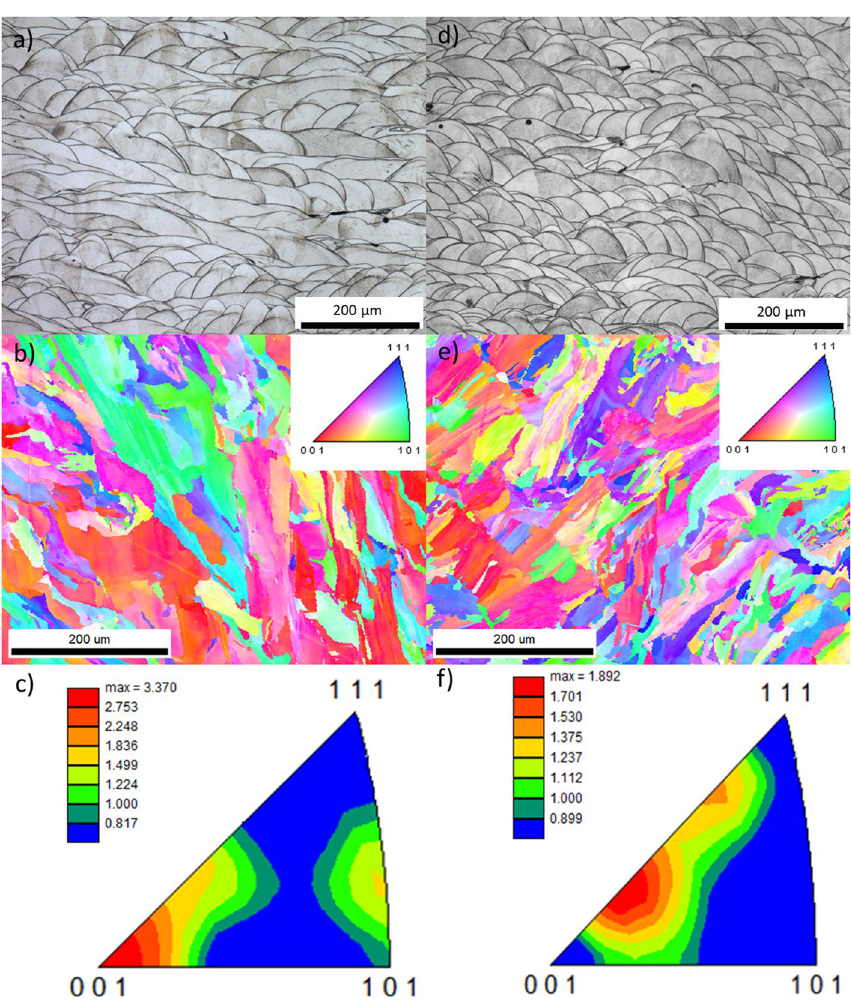
Figure 8. Optical micrographs of the etched microstructure, with the melting pools visible (in CoCr printed from virgin powder ( a ) and the reused powder ( c )) EBSD results and orientation maps (in CoCr printed from virgin powder ( d ) and the reused powder ( e )) and inverse pole figures (IFP) in [001] direction (in CoCr printed from virgin powder ( c ) and the reused powder ( f